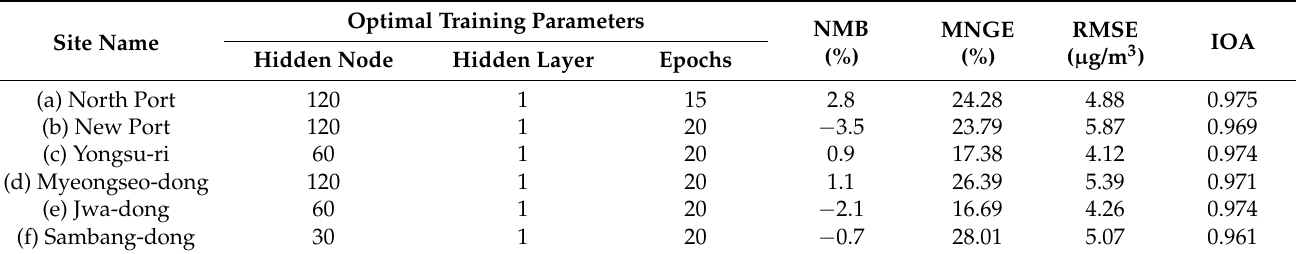
Table 8. Statistical comparison of RNN-LSTM-modeled and AQMS-observed PM 2.5 (North Port and New Port: AQMS + ASOS + anchored ships; other sites: AQMS +